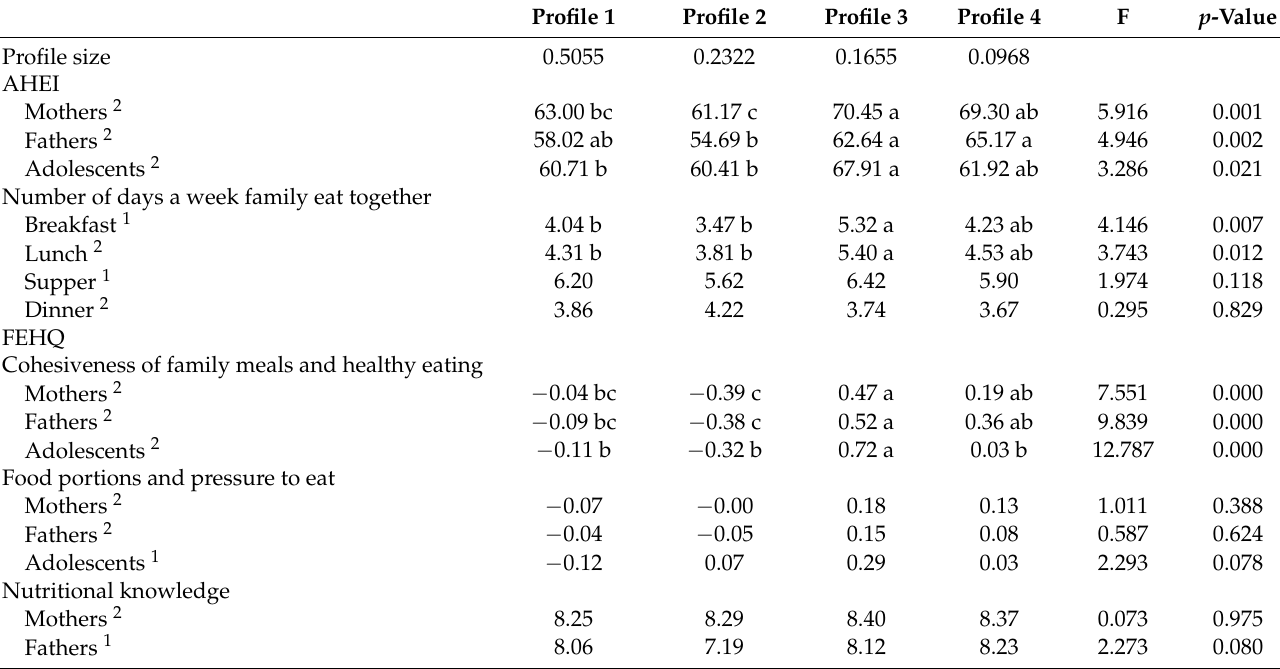
Table 4. Differences between the four latent classes’ profiles according to satisfaction with food- related life (SWFoL), adapted healthy eating index (AHEI), family meal frequency, family habits questionnaire (FEHQ) and nutritional